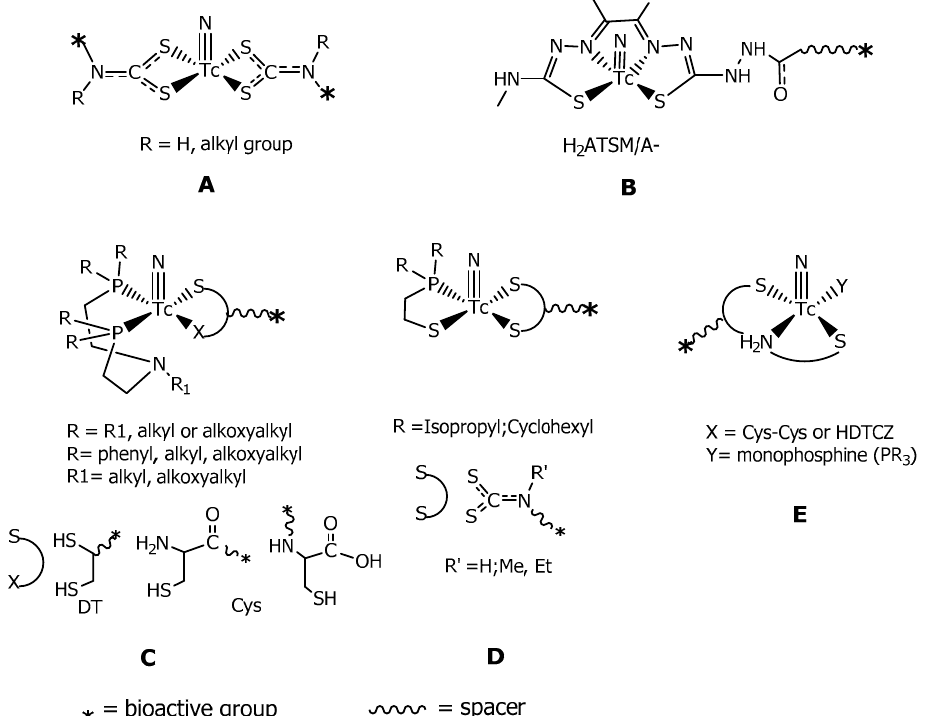
Figure 15. Schematic drawing of different TcN-based platforms suitable for the preparation of target-specific radiopharmaceuticals.